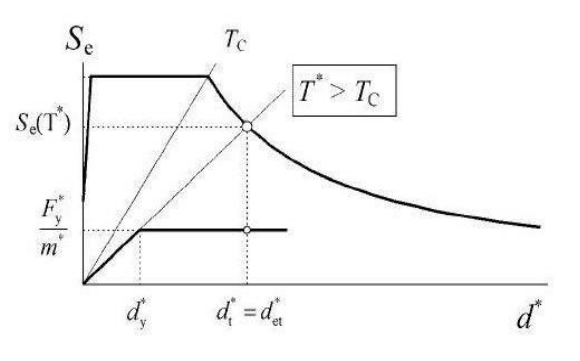
Fig. 11. Long-period range.